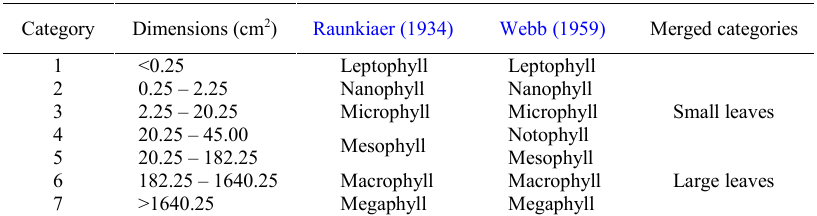
Table 1: Leaf size classes (after Malhado et al. 2009)